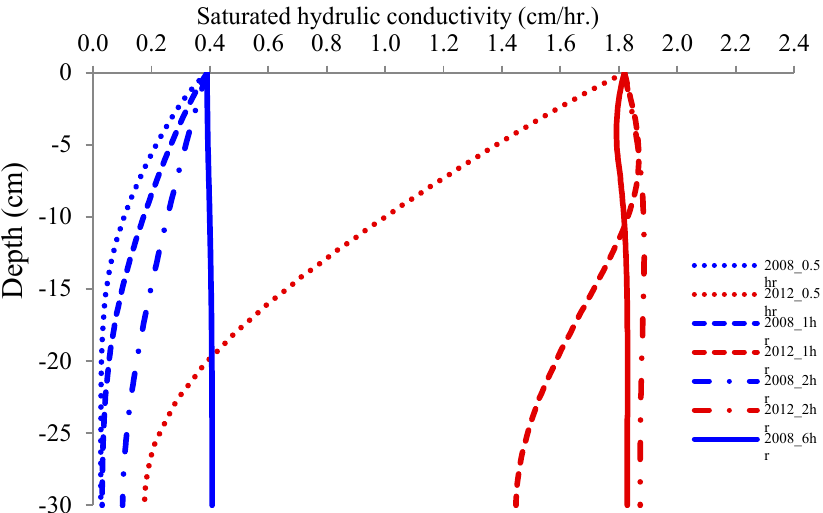
Figure 4. Saturated hydraulic conductivity changes with depth under organic management using the numerical Hydrus-1D model in 2008 and 2012.